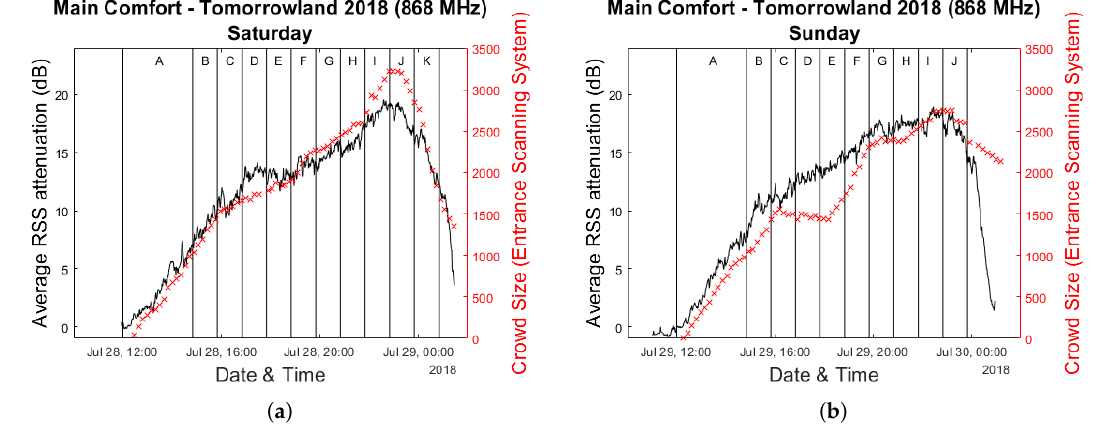
Figure 5. Evolution of the average RSS attenuation within the Main Comfort Environment, overlaid with the scanning system data. ( a , b ) show this for respectively Saturday 28 July 2018 and Sunday 29 July 2018.